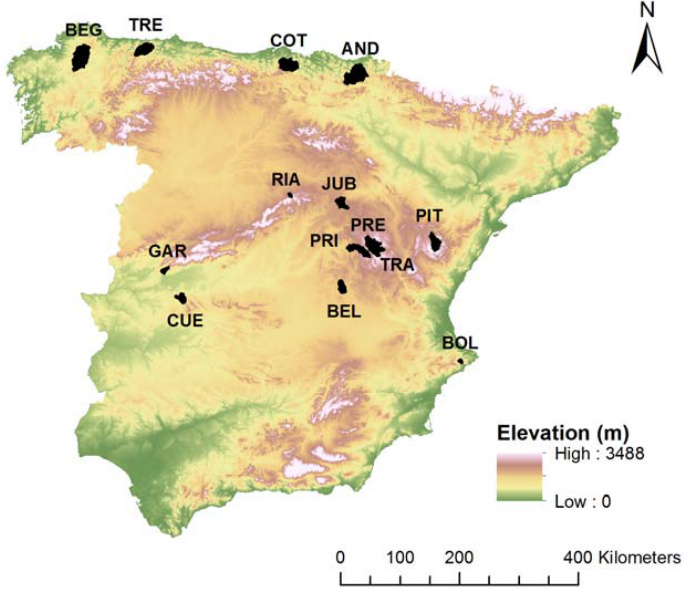
Figure 1. Location of the selected basins.